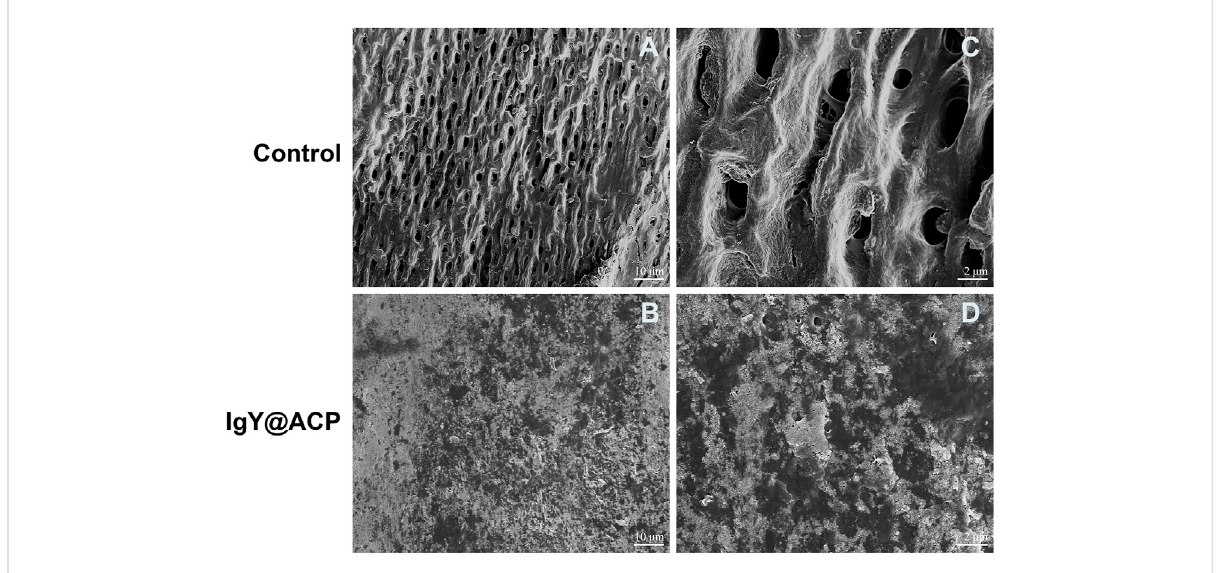
FIGURE 7 SEM micrographs of the rat dentin surface after treatment with the control (A) and IgY@ACP (B) for 4 days. (C) and (D) correspond to the enlarged images of (A) and (B) , respectively.